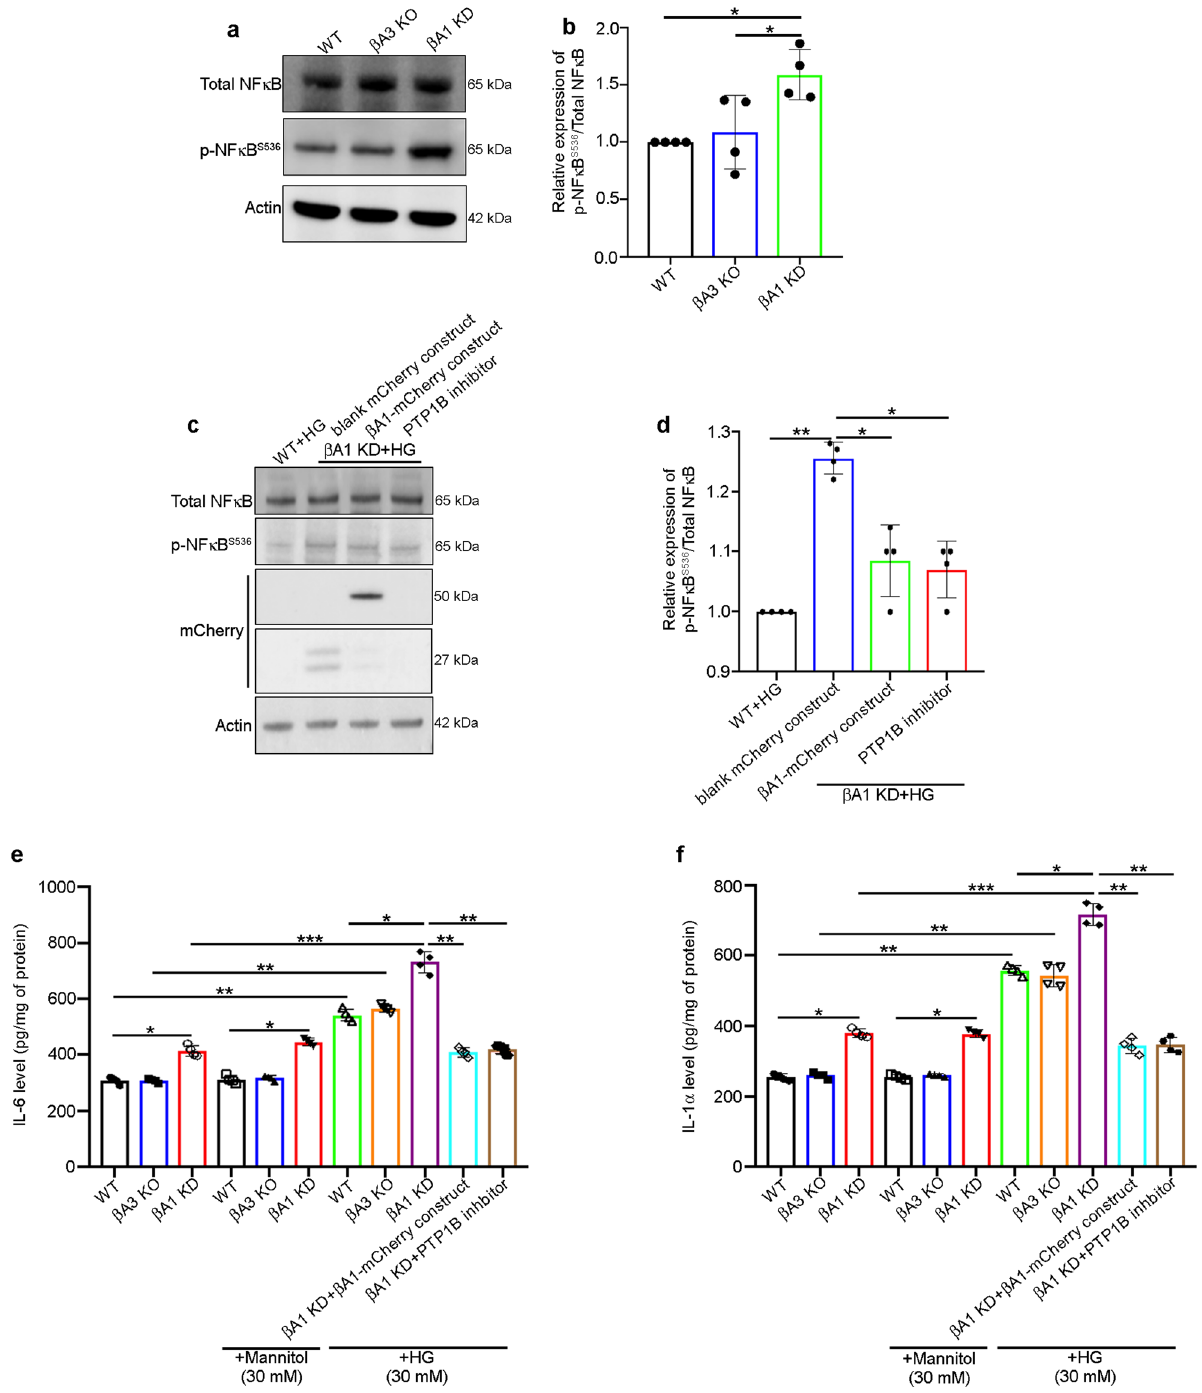
Fig. 6 β A1-crystallin regulates in fl ammation in retinal astrocytes. a Representative western blot and b densitometry graph showing increased phosphorylation of NF κ B at serine 536 (p-NF κ B S536 ) in untreated (cultured in 5 mM D -Glucose containing medium) β A1 KD astrocytes, relative to WT cells. β A3 KO cells did not show such change in p-NF κ B S536 levels. n = 4. * P < 0.05. c , d β A1 KD astrocytes transfected with β A1-mCherry construct for 48 h or treated with 10 μ M of PTP1B inhibitor (MSI-1436) for 1 h, prior to HG (30 mM) exposure for 6 h rescued the levels of p-NF κ B S536 , compared to β A1 KD cells transfected with blank mCherry construct and then exposed to HG. β A1-crystallin overexpression was con fi rmed by mCherry western blot. n = 4. * P < 0.05, ** P < 0.01. e IL-6 and f IL-1 α levels showed marked increase in HG-exposed WT, β A3 KO, and β A1 KD astrocytes, compared to untreated cells. β A1 KD astrocytes showed increased levels of both cytokines relative to WT or β A3 KO cells. ( e , f ) Overexpression of β A1-crystallin (using β A1-mCherry construct) in β A1 KD astrocytes or treatment with 10 μ M of PTP1B inhibitor (MSI-1436) for 1 h, prior to HG (30 mM) exposure for 6 h, rescued the levels of IL-6 and IL-1 α . n = 4. * P < 0.05, ** P <